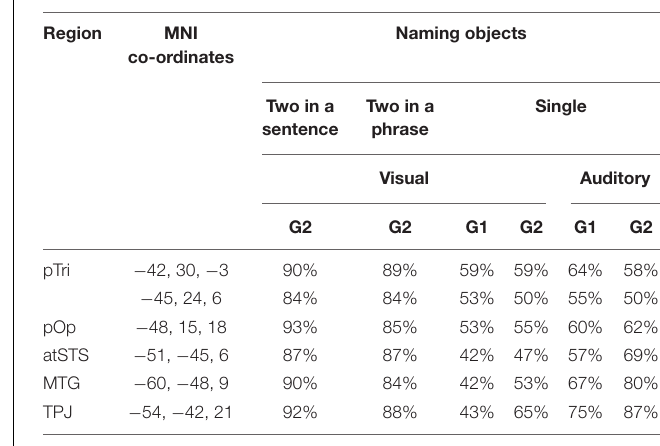
TABLE 3A | Consistency of activation in regions of interest.